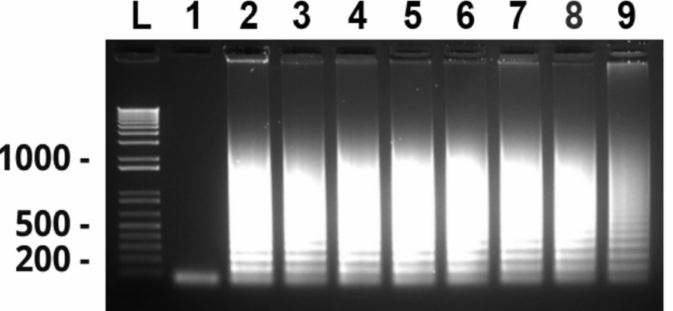
Figure 6. Direct detection of T. tenax among clinical samples without prior DNA extraction. Lane 1: nuclease-free water as a negative control; lane 2: positive controls with 100 ng T. tenax genomic DNA; lanes 3–10: eight microscopically confirmed trichomonad samples of individually owned pet dogs containing two cells per sample. LAMP results are detected by gel electrophoresis. One of three repeats is